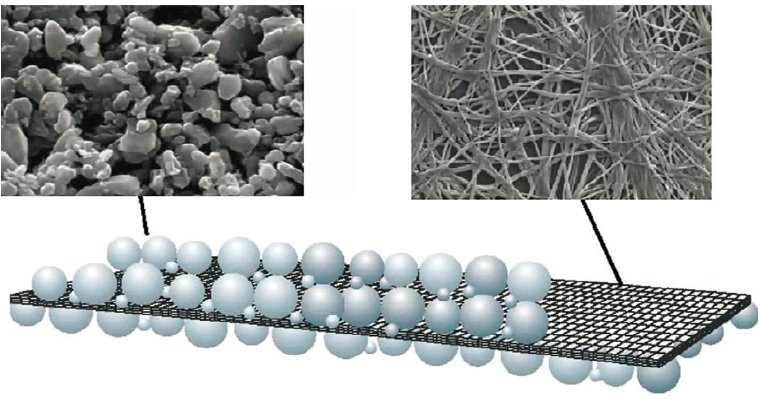
Figure 9. Schematic and SEMs of a Degussa composite separator [54].